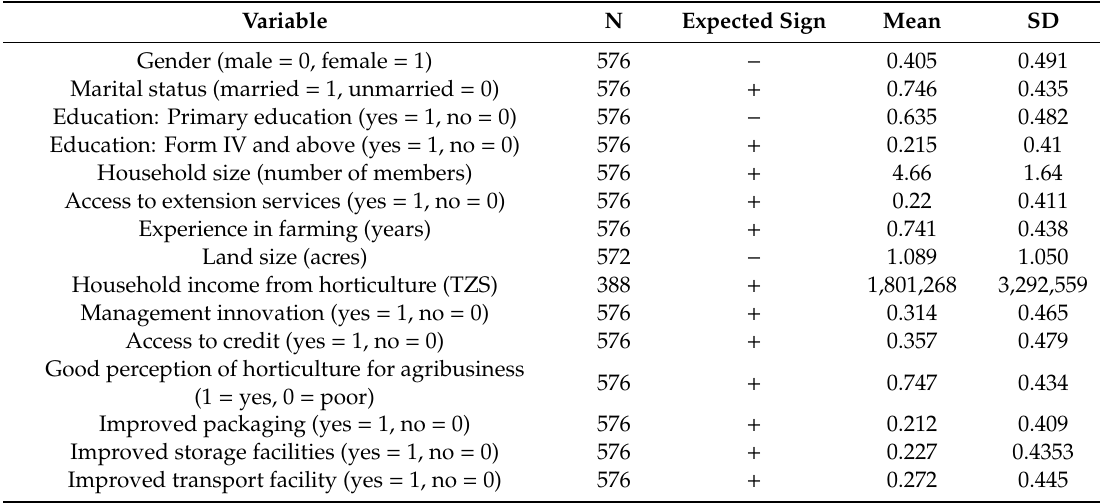
Table 1. Independent variables and descriptive